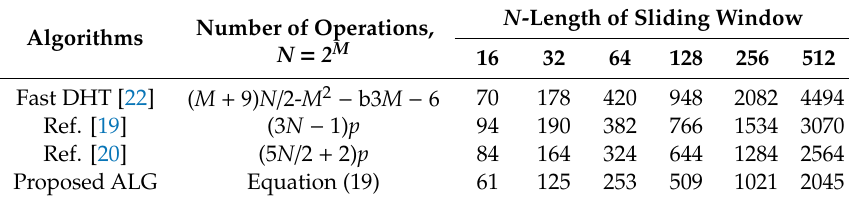
Table 3. Comparison of the tested algorithms with respect to additions for computing sliding DHT with p = 2.